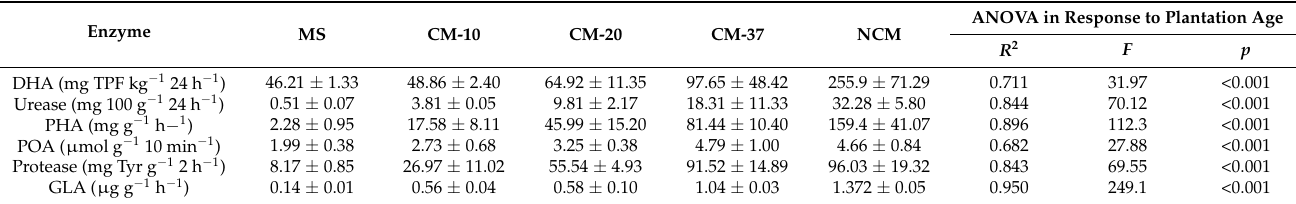
Enzyme Table 2. Activities of soil enzyme at different Caragana microphylla plantations.